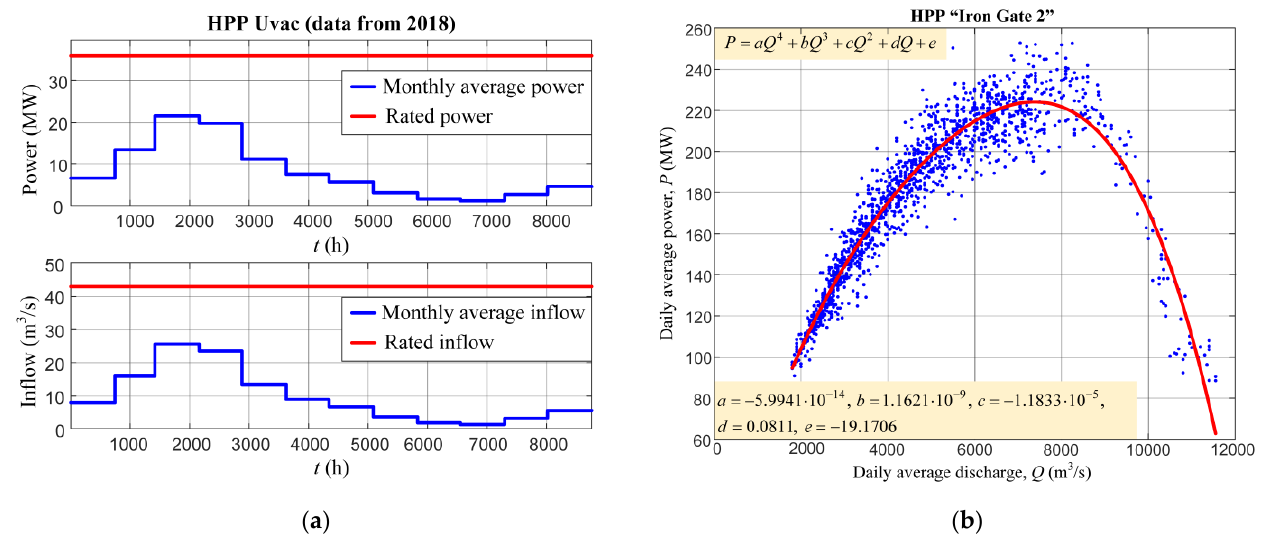
Figure 6. ( a ) Representative generation profile for HPP “Uvac” ; ( b ) representative generation curve for HPP “Iron Gate 2” . for HPP “Iron Gate